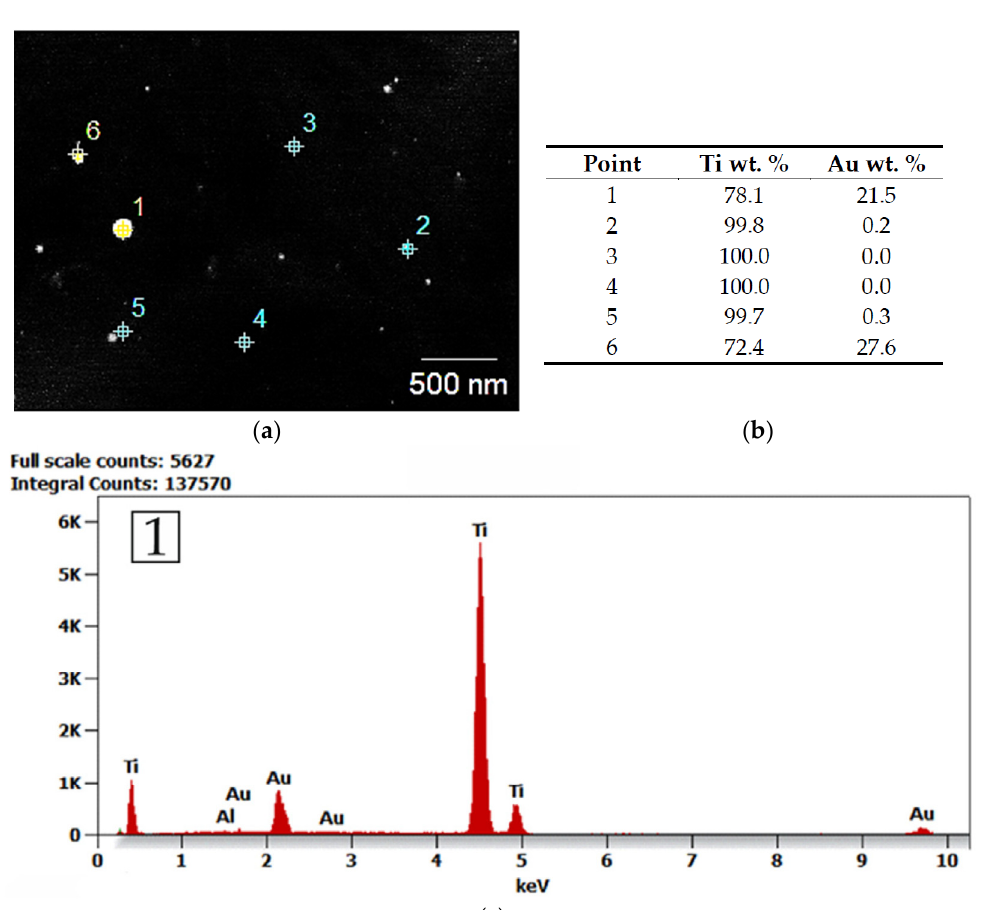
Figure 9. EDS quantitative chemical elements composition and energy dispersion spectrum: ( a ) spectral collection points—assessment towards the gold particles; ( b ) results of collected spectrums in wt %; ( c ) EDS spectrum of the measurement point 1.